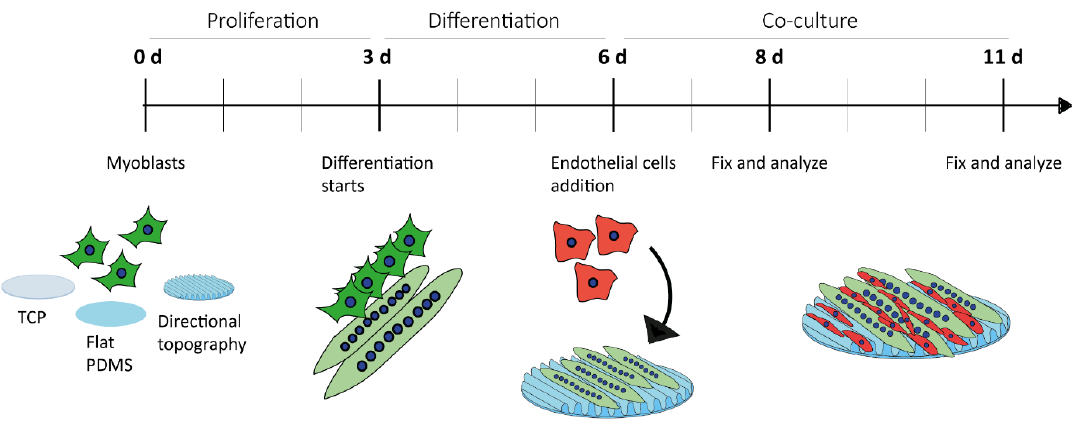
Figure 1. Experimental design. Myoblasts were in culture for three days and then differentiated